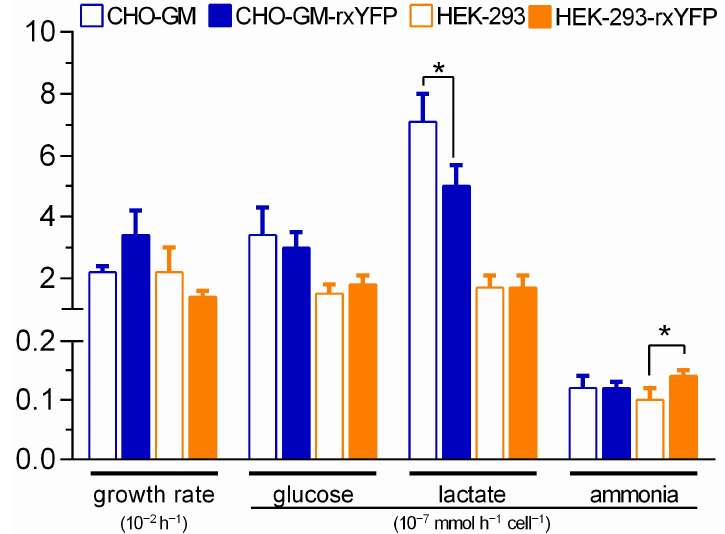
Figure 4. Growth and metabolic rate of parental and redox reporter cell lines. The specific growth rate, glucose consumption, and lactate or ammonia production during the exponential growth phase (day 0 to day 2) of parental (empty bars) and redox reporter (filled bars) cell lines is shown. Significant differences (*, p < 0.05) between reporter and parental cell lines from the same cell type are indicated with solid lines.